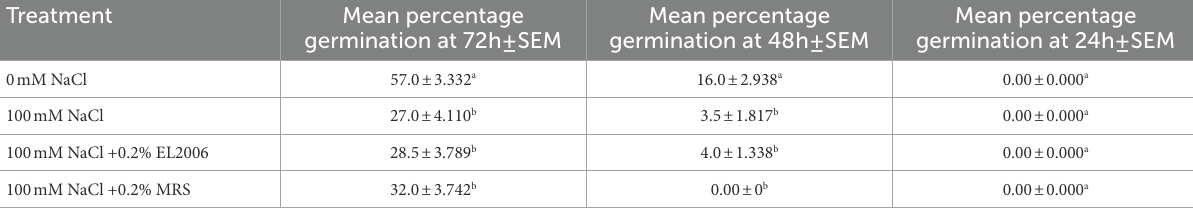
TABLE 3 Effect of treatments on mean percentage germination of corn at 72, 48 and 24 h, respectively.